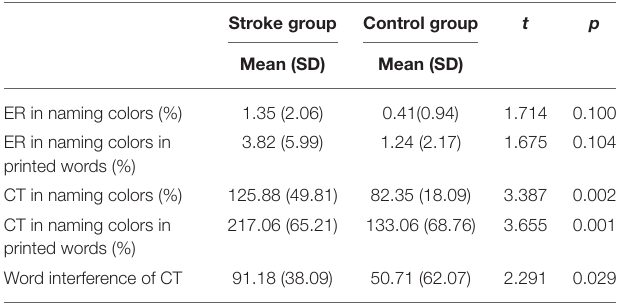
TABLE 6 | The error rates and response times in the stroop test.